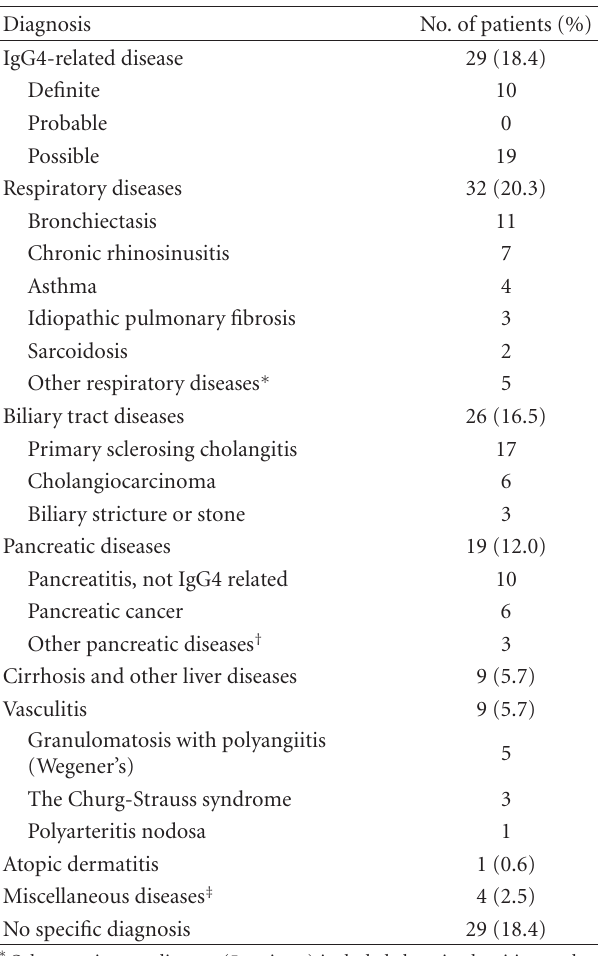
Table 2: Spectrum of diagnoses associated with high serum IgG4 Levels ( n = 158).